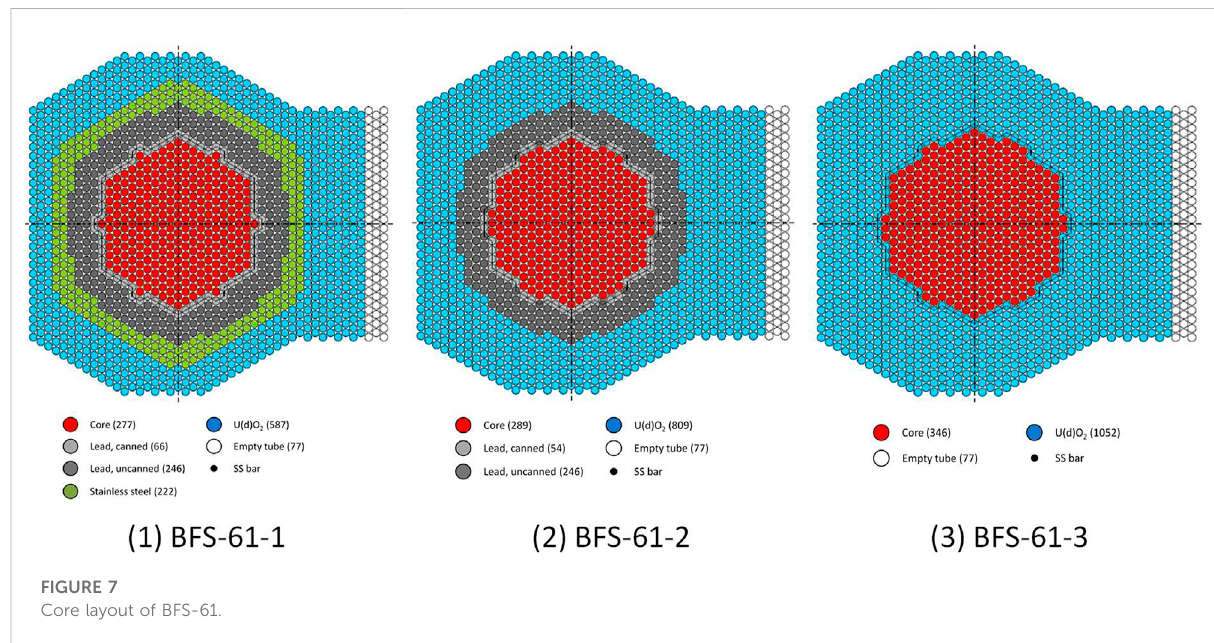
FIGURE 7 Core layout of BFS-61.